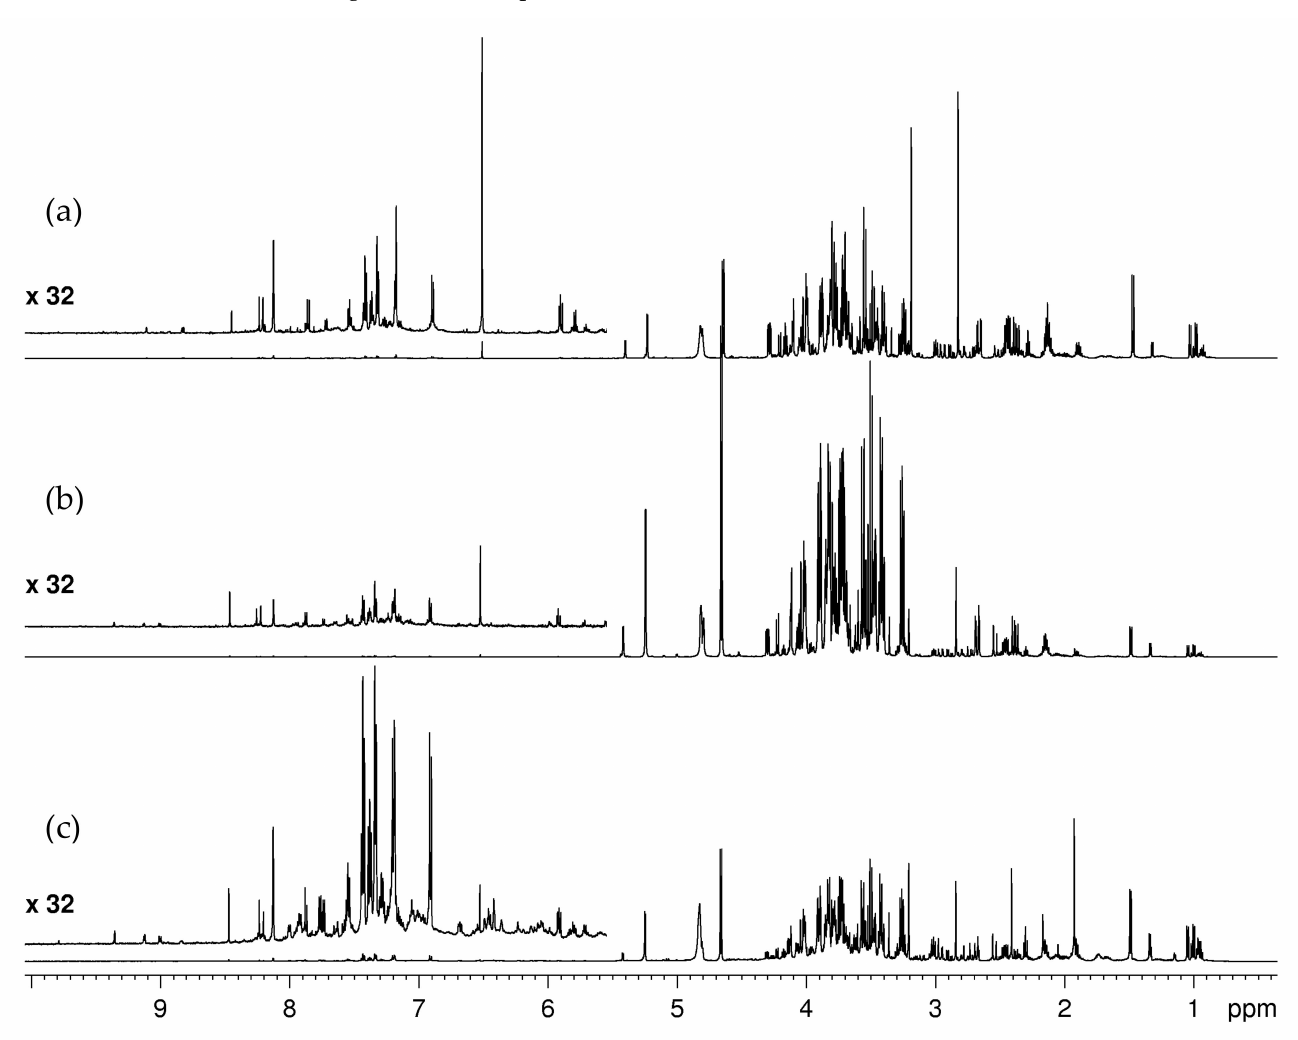
Figure 3. 1 H NMR spectra of cauliflower byproducts aqueous extracts: florets ( a ), stalks ( b ), leaves ( c